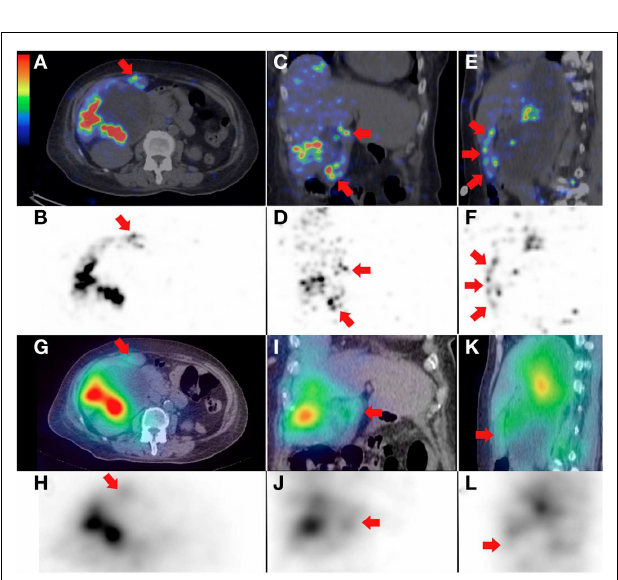
FIGURE 5 | (A–F) 90 Y PET/CT depicts in high resolution, non-target activity in a non-random distribution conforming to the anatomy of the gallbladder wall (arrows), shown here in trans-axial, coronal, and saggital planes, respectively. (G–L) 90 Y bremsstrahlung SPECT/CT shows concordant but subtle diffuse non-target gallbladder